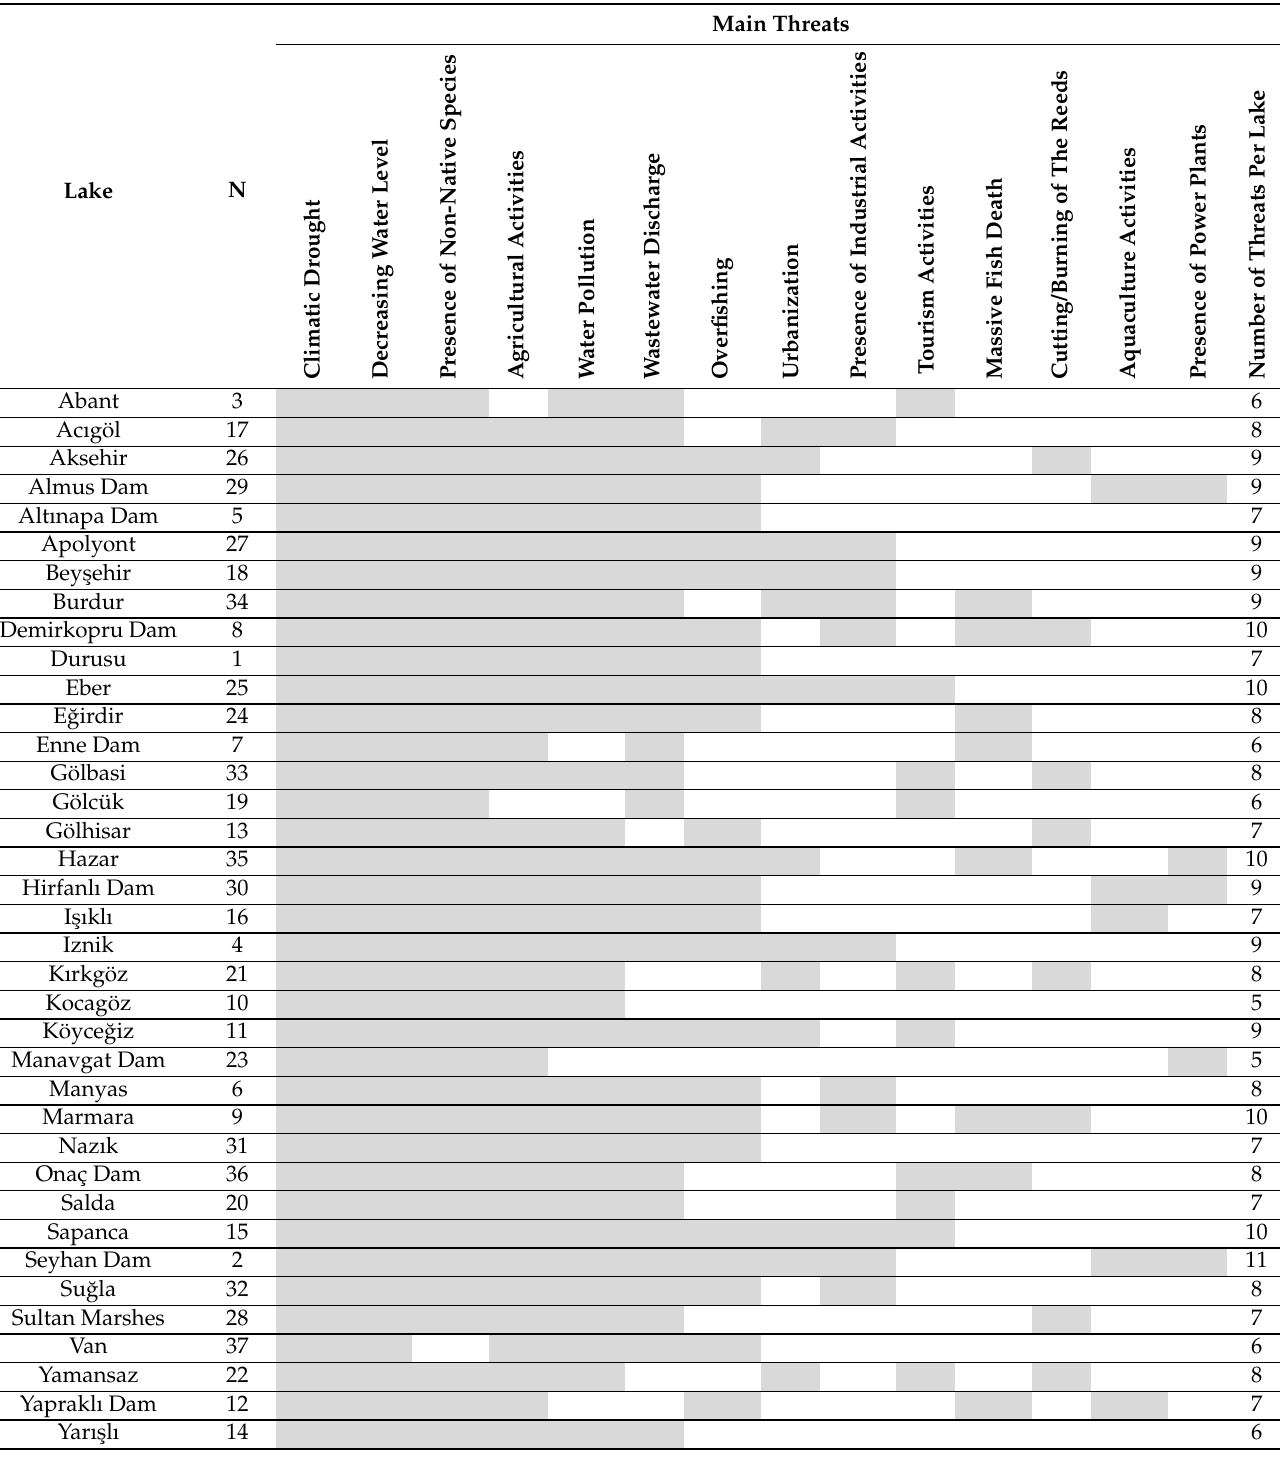
Table 3. List of the main threats reported to occur in the main lakes of Turkey (N: lake number in Figure 1 from west to east).